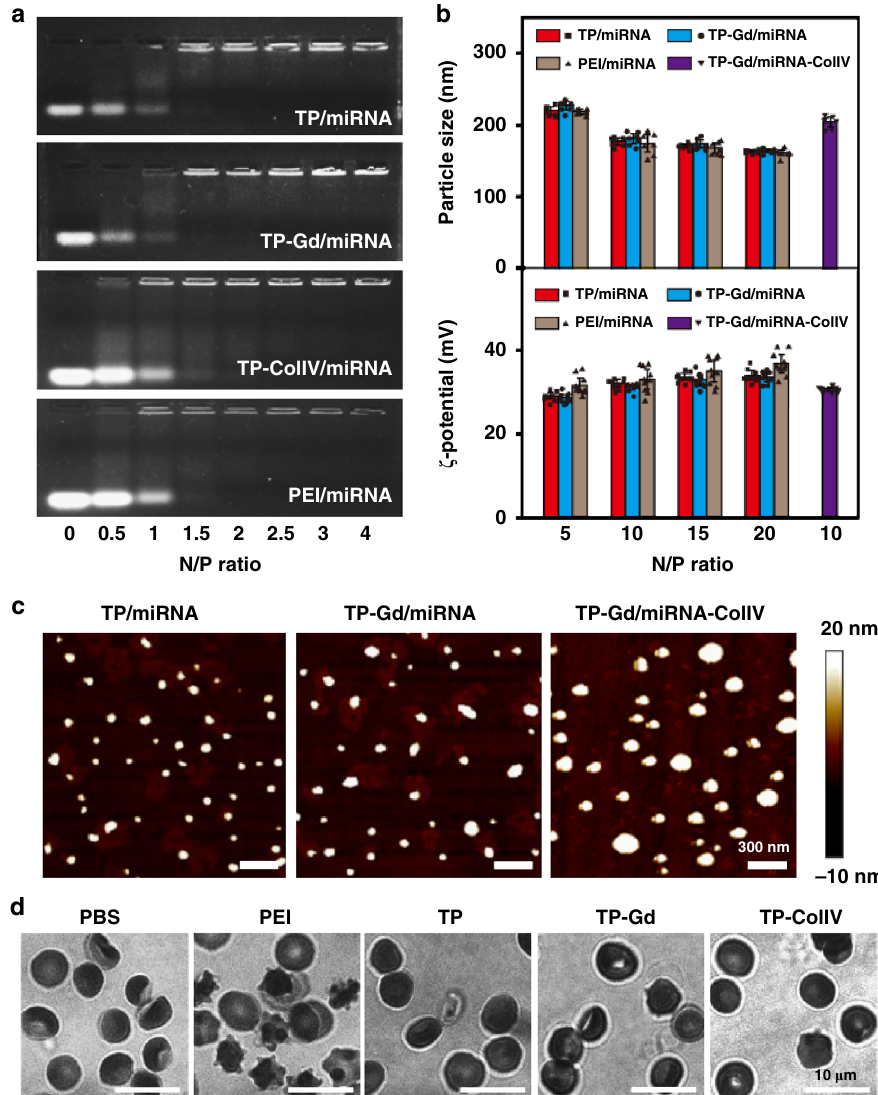
Fig. 2 a Electrophoretic mobility retardation assay of miRNA in the complexes with PEI, TP, TP-Gd, and TP-ColIV at various N/P ratios. b Particle size and ζ - potential of the polycation/miRNA complexes at various N/P ratios. c AFM images of different polycation/miRNA complexes at the typical N/P ratio of 10. d Images of red blood cells (RBCs) treated with PEI, TP, TP-Gd, and TP-ColIV at the concentration of 1 mg mL − 1 , where PBS was used as the control. ( n ≥ 7 independent experiments; error bars represent standard deviation; source data of a , b are provided as a Source Data fi